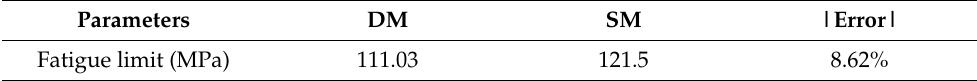
Figure 9. Fatigue limit determination based on the staircase method. Table 4. The error between the developed method (DM) and staircase methods (SM).